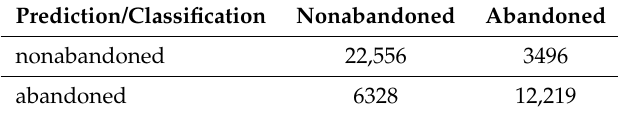
Figure 6. Convolutional network architecture for land abandonment classification. Table 1. The confusion matrix under the test